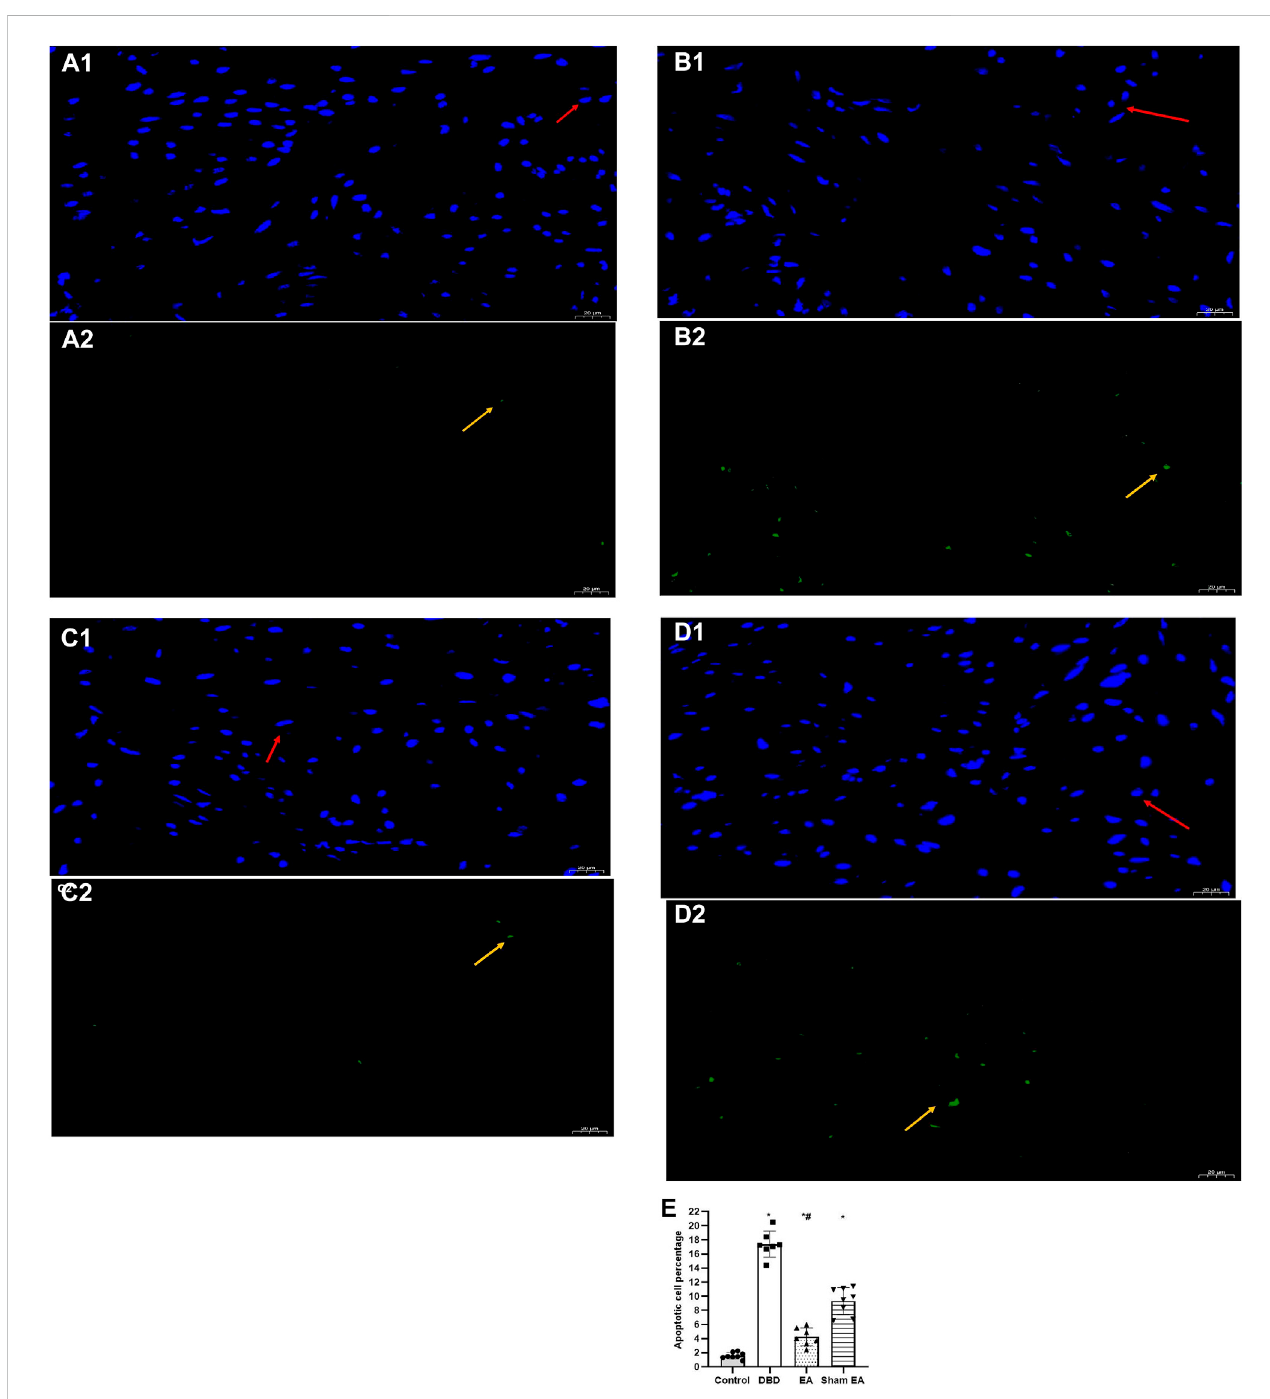
FIGURE 7 The percentage of apoptotic cells in each group on TUNEL images. Representative micrographs show TUNEL-positive cell expression: normal nuclei showed blue light, while apoptotic nuclei showed green light (magni fi cation ×400). Bar graphs show the quantitative image analysis. (A1-A2) . Control group: n =8rats; (B1-B2) .DBDgroup: n =7rats; (C1-C2) .EAgroup: n =7rats; (D1-D2) .ShamEAgroup: n =8rats; (E) .Theapoptoticcellspercentagewithinthetotal number of cells in each area. Results are expressedas mean ± standard error of the mean. * p < 0.01 versus the Control group. # p < 0.01 versus theSham EA group (one-way ANOVA). The yellow arrowheads indicate the apoptotic cells. The red arrowheads indicate normal